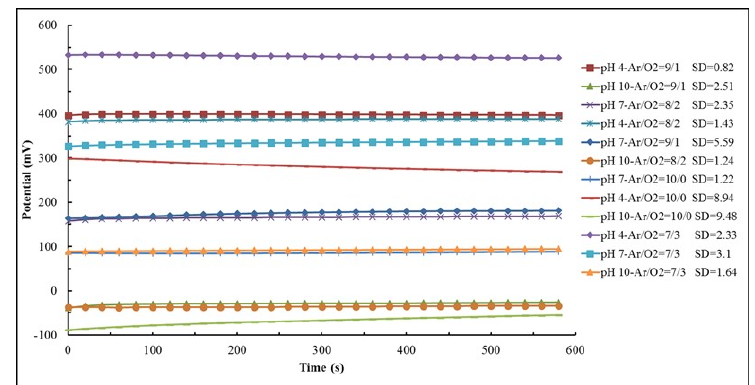
Figure 4. Measured potentials versus time in pH 4, pH 7 and pH 10 for different Ar/O 2 gas ratios (sccm) along with the standard deviation values.